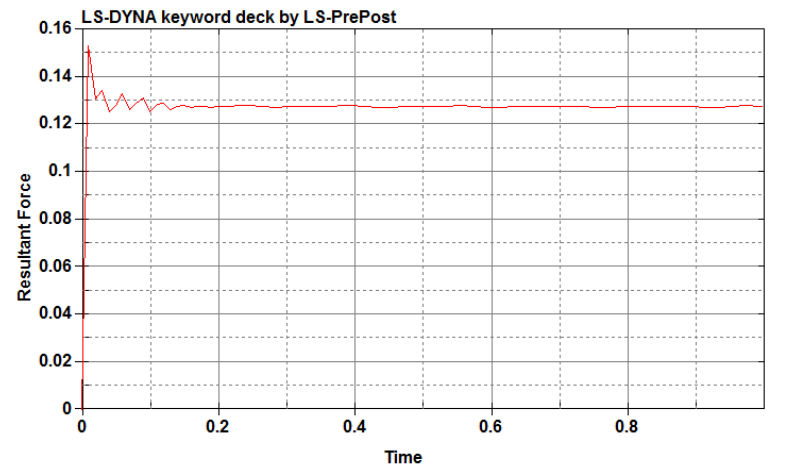
Figure 11: Resultant force between the upper and lower parts with time .